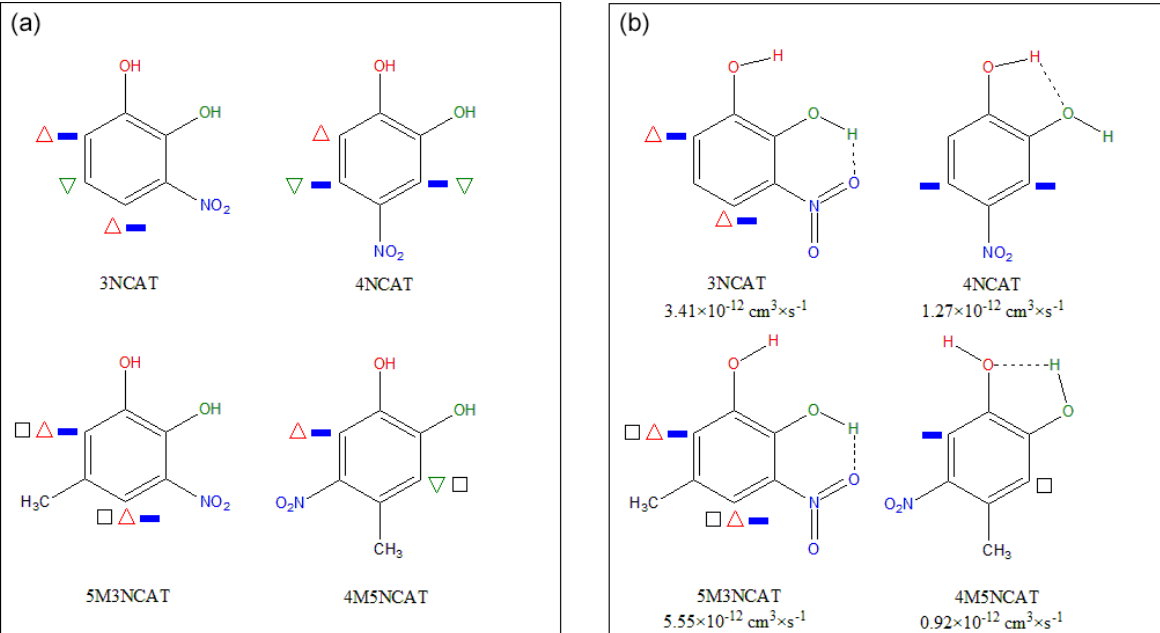
Figure 7. Electromeric effect distribution on the aromatic ring for the all investigating nitrocatechols in the present study: (a) active sites toward electrophilic attack by hydroxyl (1st OH: red triangle/2nd OH: green triangle), nitro (blue bar), and methyl (black square) groups; (b) internal interactions of the substituents and consequences on the reactivity based on the gas phase FT-IR spectra.